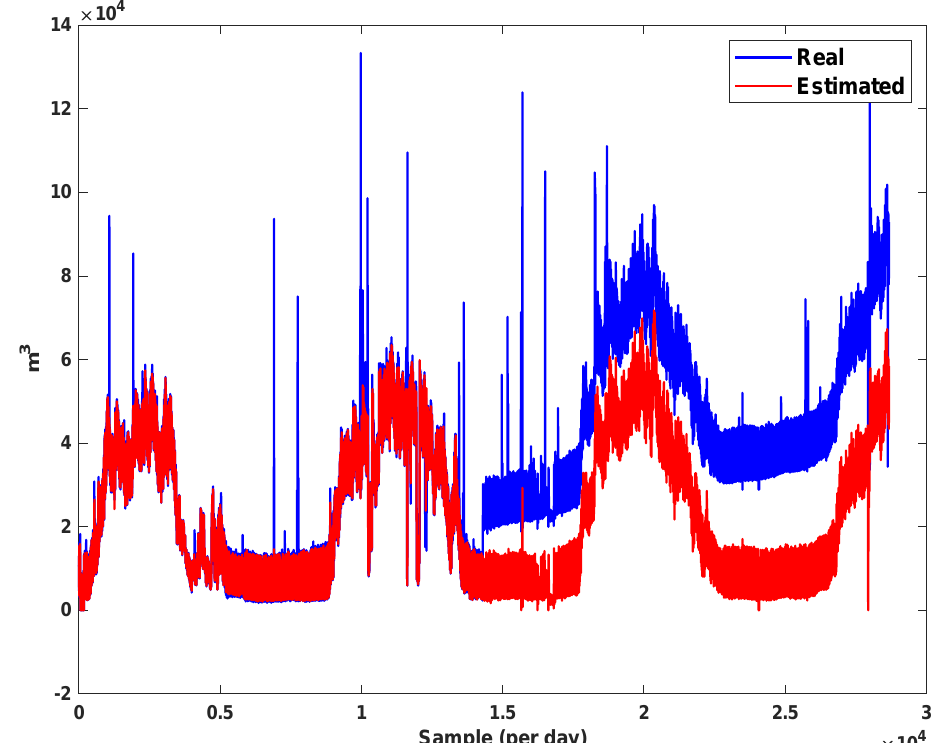
Figure 25. Detection fault 3: Peak of